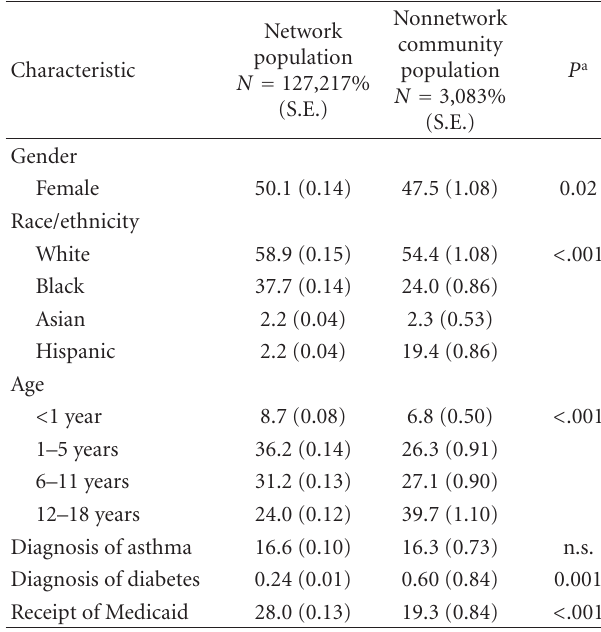
Table 1: Demographic and clinical characteristics of the network- enrolled and the nonnetwork community populations in the philadelphia metropolitan area ( N = 130,300